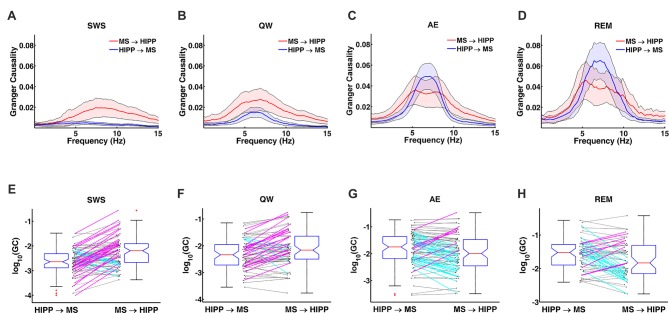
Changes in GC during non-theta (SWS, QW) and theta (AE, and REM sleep) states. (A–D) Group averaged GC between hippocampal LFP and MS activity in MS→HIPP (red) and HIPP→MS directions (blue). (E–H) GC of individual neurons in the two directions for each state.